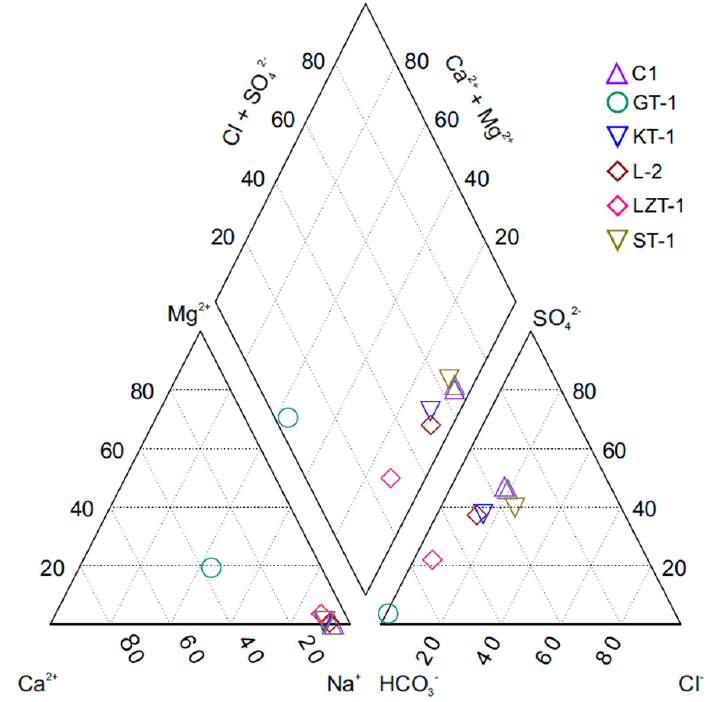
Figure 2. Piper diagram with chemical characteristics of thermal waters (based on [42,43,49,56]). Table 2. Chemical and isotopic composition of thermal waters (based on [42,43,49,56]);